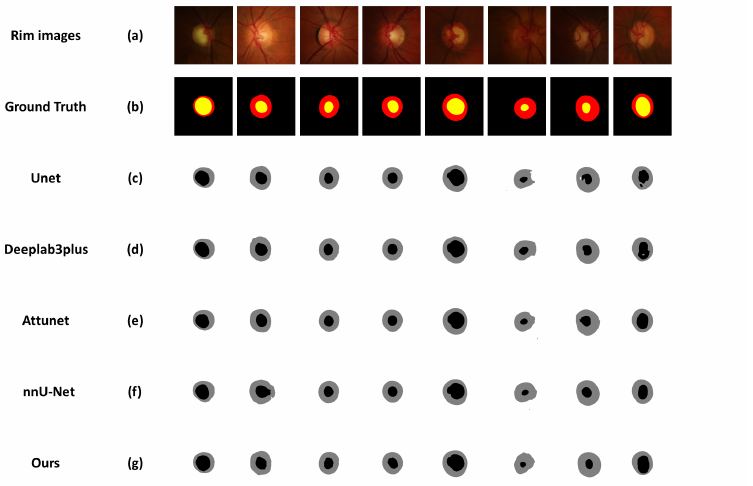
Figure 8. Visualization of OD and OC segmentation results on RIM-ONE v3 dataset. From top to bottom:( a ) RIM-ONE v3 images. ( b ) The ground truth. ( c ) The segmentation results of Unet. ( d ) The segmentation results of Deeplabv3plus. ( e ) The segmentation results of AttU-Net. ( f ) The segmentation results of nnU-Net. ( g ) The segmentation results of our